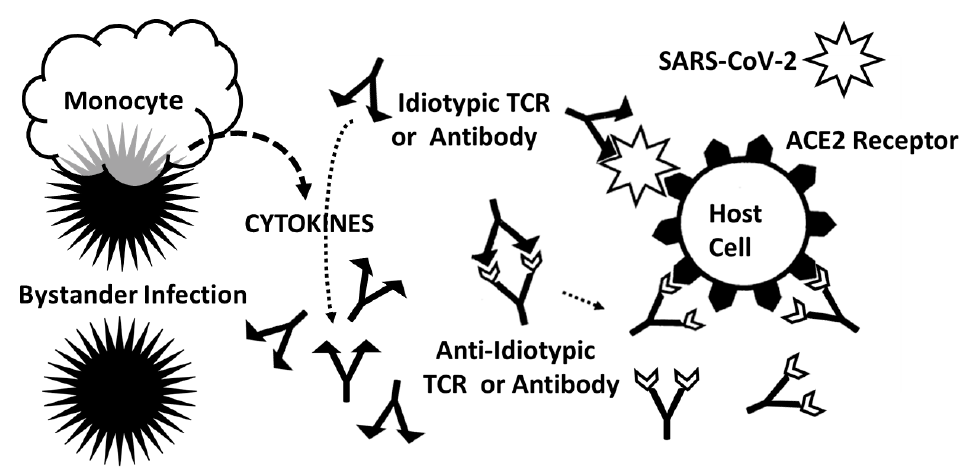
Figure 12. Schematic representation of the bystander activation theory of autoimmune disease [116– 118]. The theory suggests that non-specific bystander infections stimulate a hyperinflammatory state in the innate immune system that results in over-production of cytokines (large dashed arrow from monocytes) enabling over-production of idiotypic TCRs and/or antibodies (dotted arrow from idiotypic TCR or Antiibody). The unusual production of idiotypic TCRs/antibodies then initiates the production of anti-idiotypes (small dotted arrow from anti-idiotypic TCR or antibody) that mimic the initiating microbes. This theory could explain both why only some individuals develop autoimmune diseases following COVID-19 (only those with co-infections do so) and also why the resulting TCRs mimic both SARS-CoV-2 and host antigens. It does not, however, explain why the bacterial mimicry observed here is limited to the most common co-infections found among COVID-19 patients.